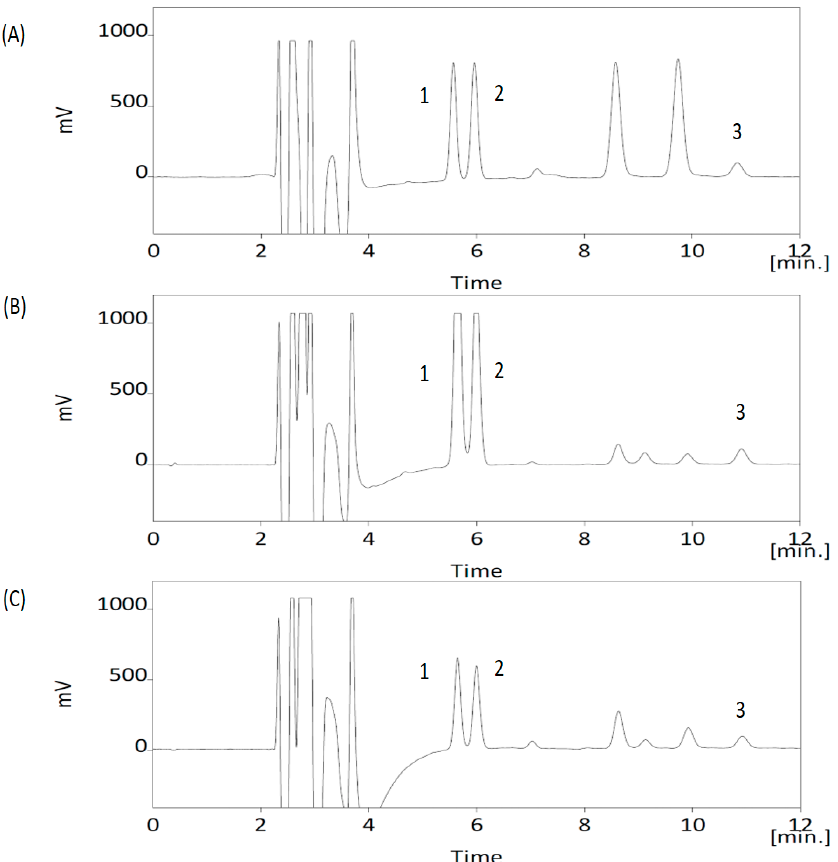
Figure 2. The HPLC-ECD chromatographs of neurochemicals ( A ) standard solution (100 ng / mL), ( B ) basal level striatum sample: (1) dopamine (471.14 ng / mL), (2) DOPAC (2013.33 ng / mL), (3) HVA (657.50 ng / mL), ( C ) MPTP group at striatum sample: (1) Dopamine (86.15 ng / mL), (2) DOPAC (104.93 ng / mL), (3) HVA (67.46 ng / mL). ECD, electrochemical detection.